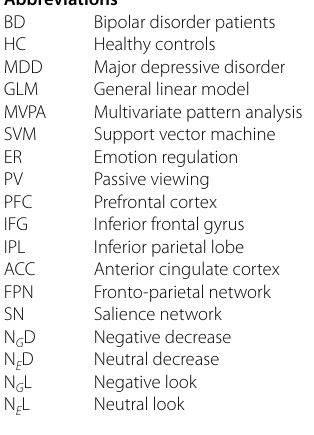
Table S3. Clusters corresponding to the top 5% of the weight contribu- tion in significant classifications. Table S4. Top 10 regions contributing to the significant group classifications based on the combined cluster size . Figure S1. Statistical parametric maps of the contrast Negative Decrease—Negative Look and Neutral Decrease—Neutral Look . Figure S2. Weight map of positive and negative voxel-wise weight contribution in the within-group classifications. Figure S3. Amygdala activation for the contrast Negative Look—Negative Decrease for the HC group ( x y 4, z = − = −